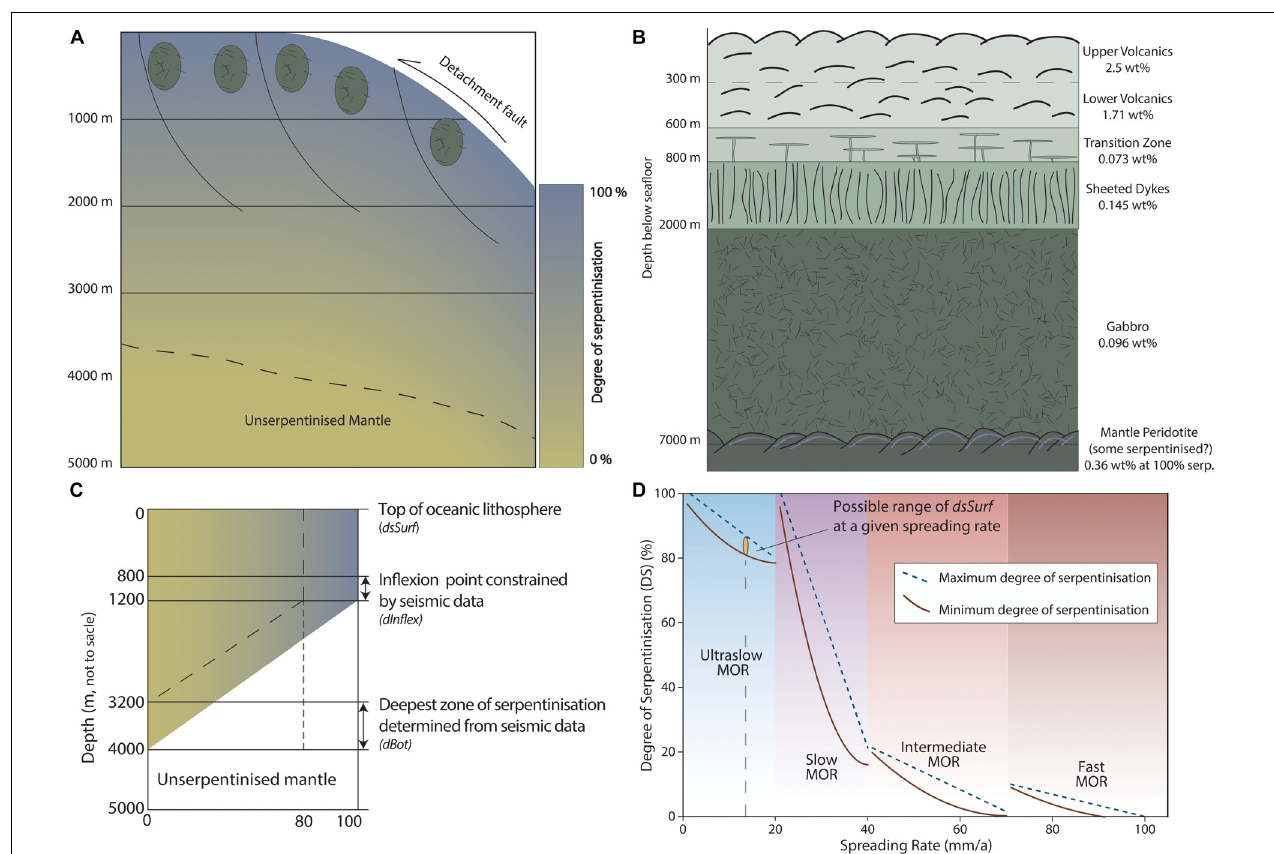
FIGURE 2 | Schematic cross sections of upper oceanic lithosphere produced at (A) slow spreading ridges (full spreading rate < 40 mm/a) where tectonic exhumation of the lithospheric mantle occurs, and (B) fast spreading ridges (full spreading rate > 40 mm/a) where the typical column of oceanic crust consisting of basalts, dykes, and gabbros is formed. At these slow ridges (A) , the mantle lithosphere is exposed to seawater, and undergoes serpentinization to a depth of ∼ 3200–4000 m. Weight percentages of carbonate for each layer are taken from Kelemen and Manning (2015). (C) Parameterization of the seismic relationship